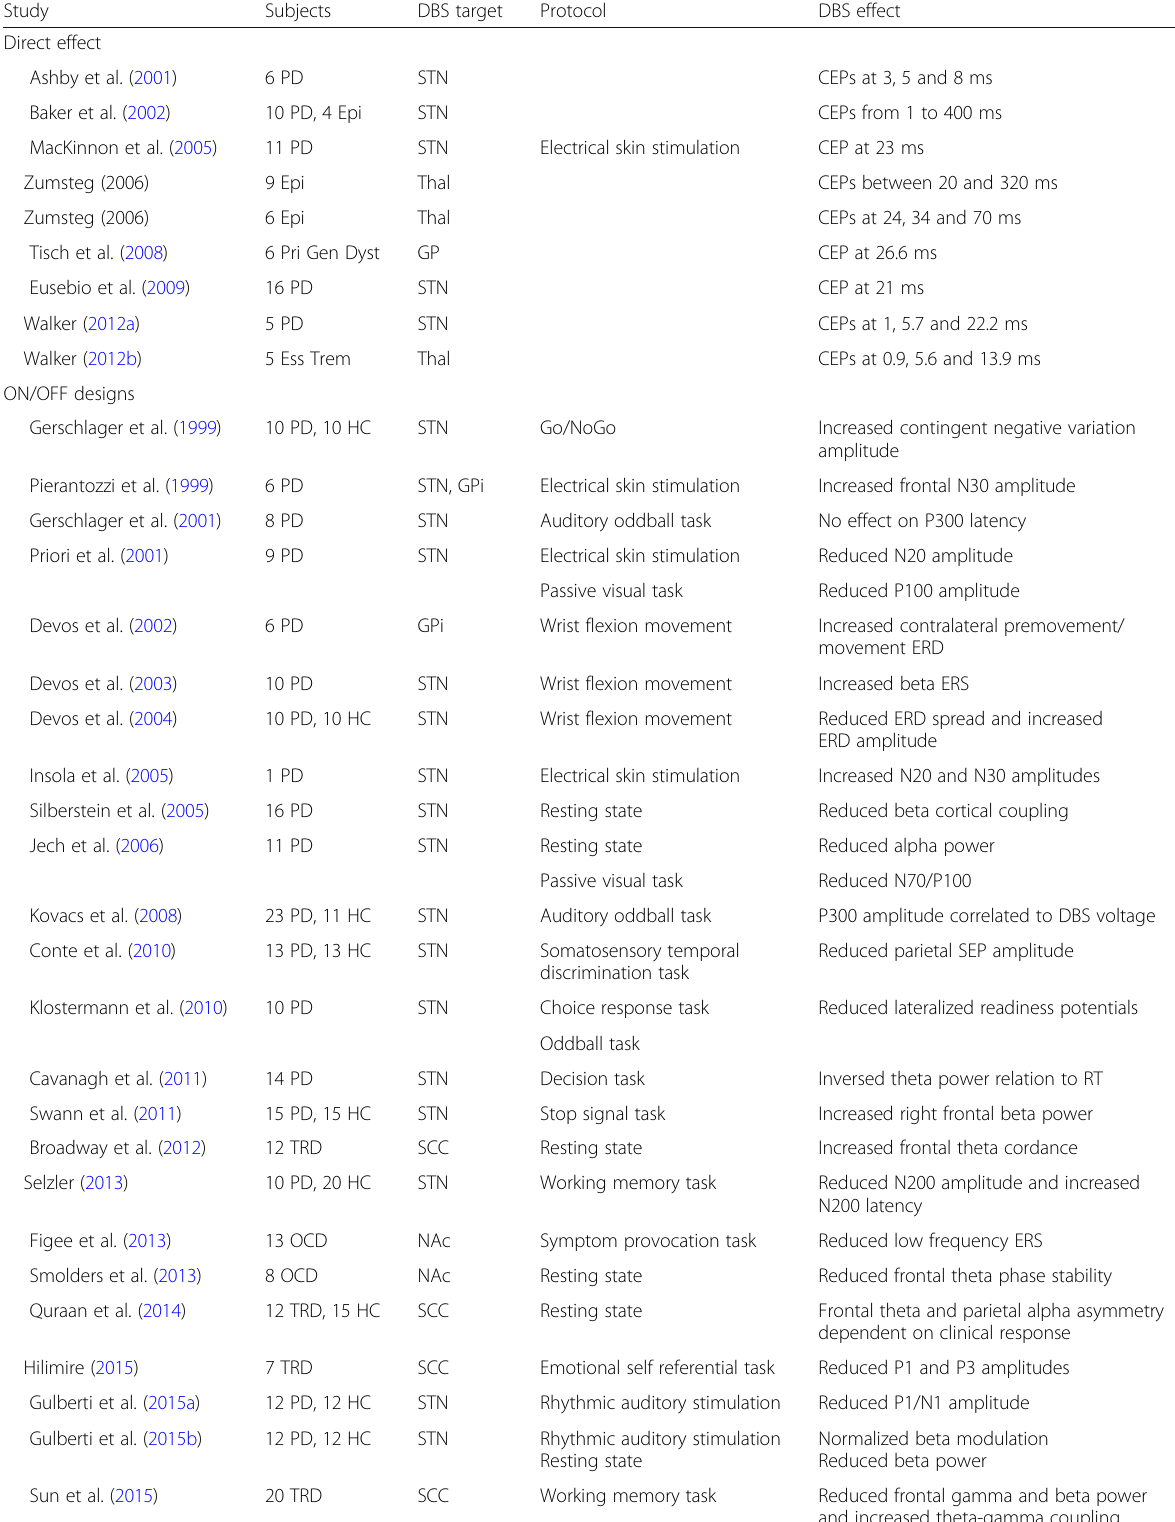
Table 1 Summary of EEG DBS studies and their principal results. Subjects number were given only for those who had direct stimulation or ON/OFF DBS